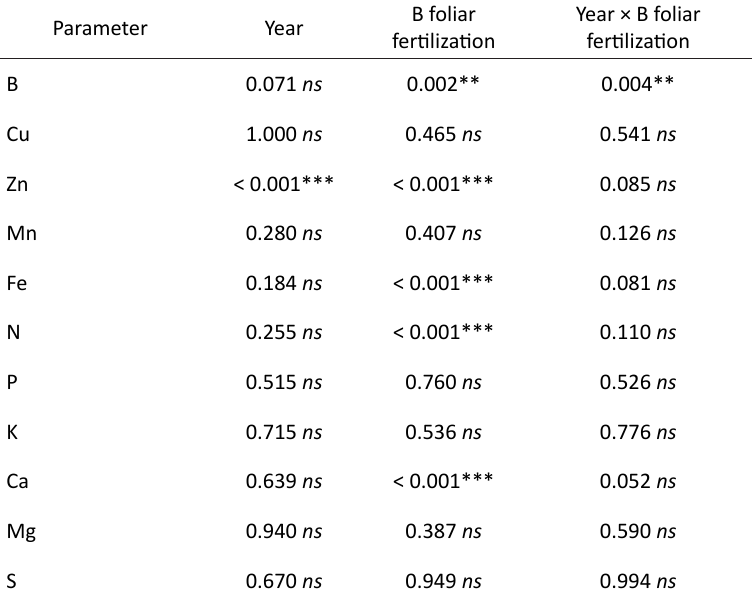
Table 3. P values ( p > F) in fixed effect tests for the nutrient content of winter